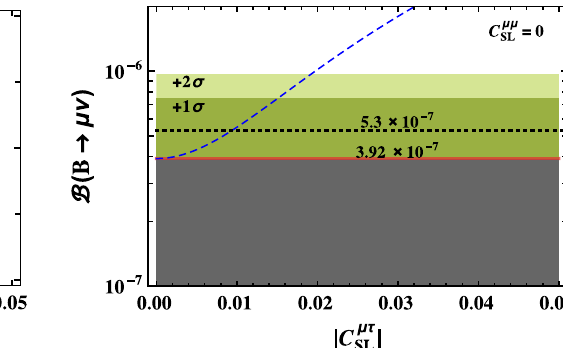
Fig. 1 Branching ratio of B → μν with | C (cid:5)(cid:5) (cid:4) | = 0). The left panel plots the contours in | C μμ ( | C (cid:5)(cid:5) (cid:4) VL andthebluedashedlineintherightpanelgivesthe | C B ( B → μ ¯ ν) . For both panels, the red solid and black dotted lines cor- respond to the SM (3 . 92 × 10 − 7 ) and Belle central values (5 . 3 × 10 − 7 ),